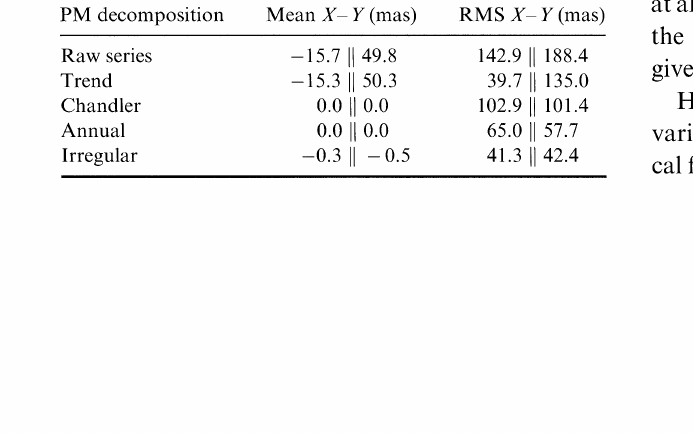
TABLE Mean and RMS of the raw series of the X-Y components of the PM and of their respective trend, CW, annual wobble and irregular part (unit: mas) PM